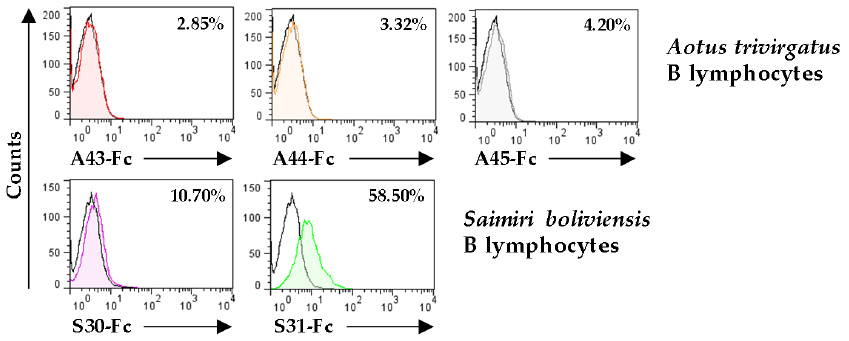
Figure 8. Analysis of the binding capacity of vCD48s to Epstein–Barr virus (EBV)-immortalized B lymphocytes. EBV-immortalized Aotus trivirgatus (top panels) or Saimiri boliviensis (bottom panels) B lymphocytes were incubated with 8 µ g / mL of each of the indicated vCD48-Fc fusion protein and analyzed by flow cytometry (shaded and colored histograms). Open histograms represent isotype controls. The percentage of positive cells is indicated in each histogram.